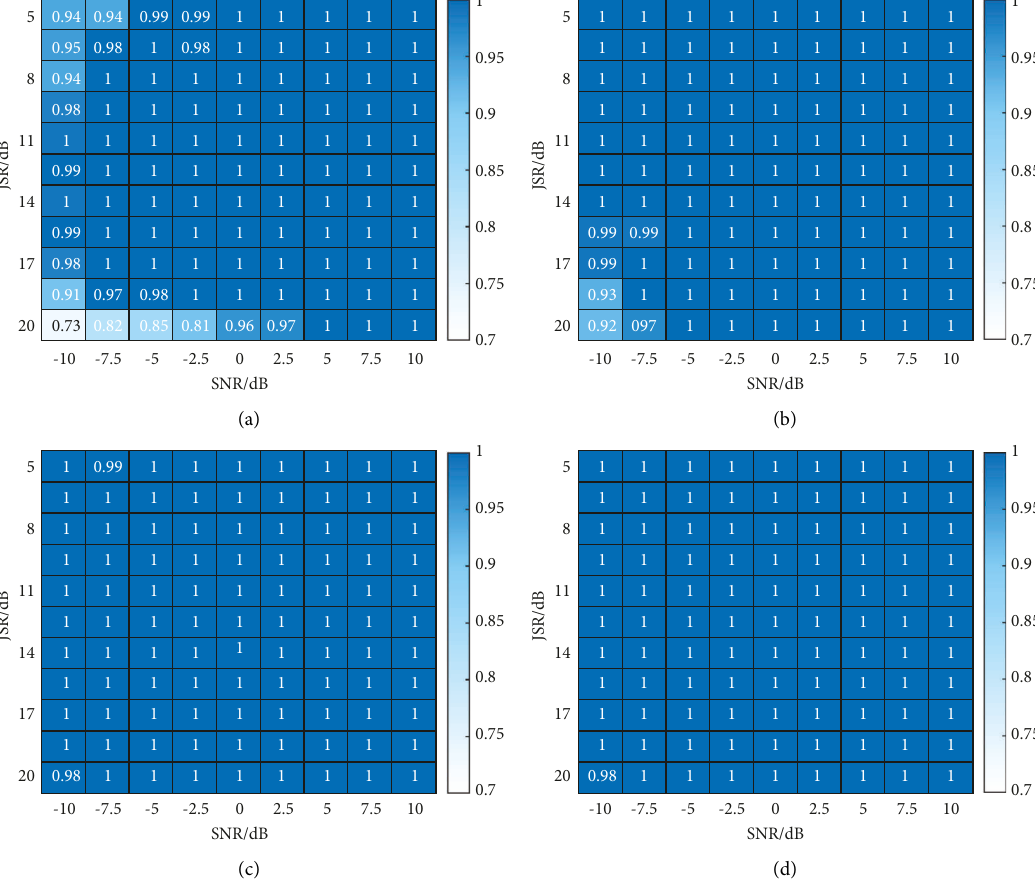
Figure 7: P A versus SNR and JSR. (a) Mode 1. (b) Mode 2. (c) Mode 3. (d) Mode 4.